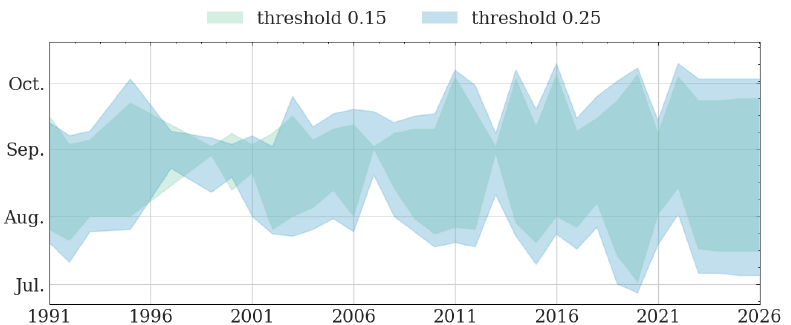
Figure 22. Estimation of 80% ice-free transit navigation window for the selected NSR.